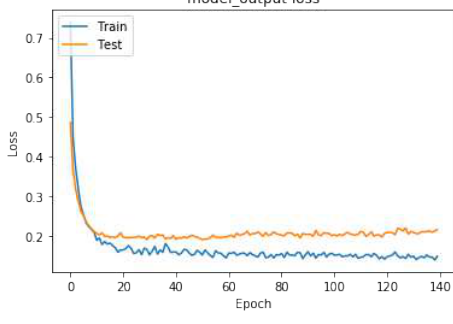
Figure 9. Epoch vs. Loss